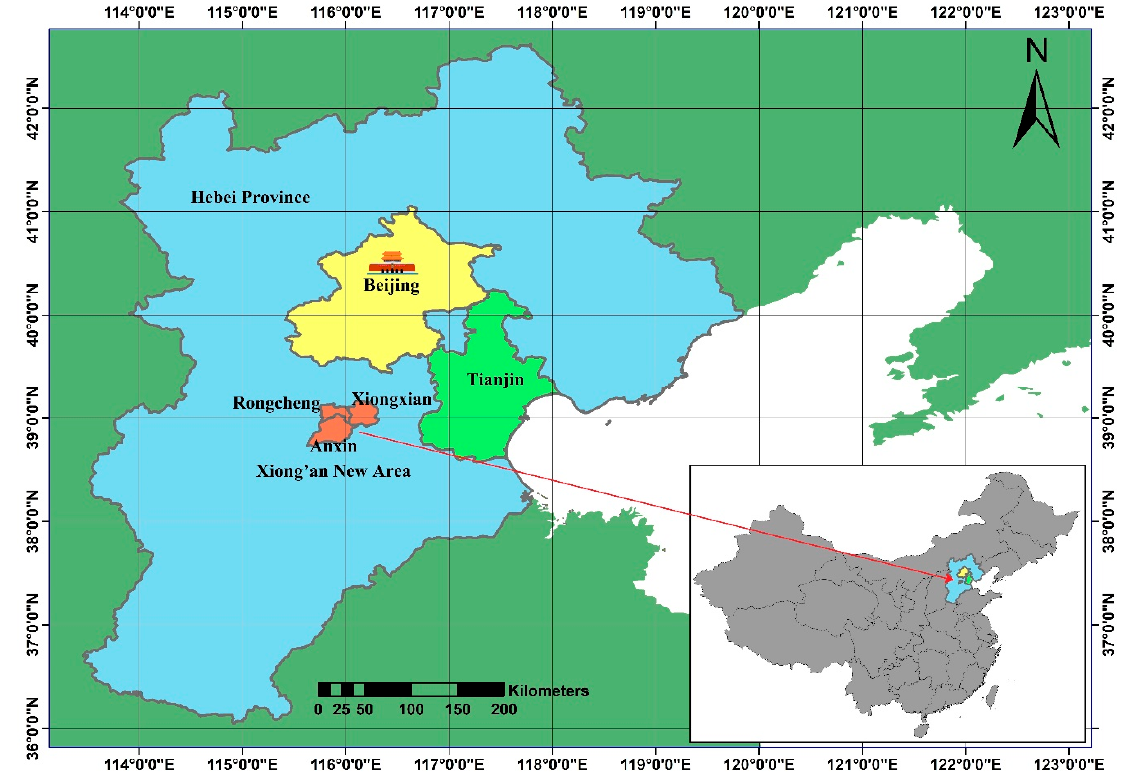
Figure 1. Geographical location of Xiong’an New Area.